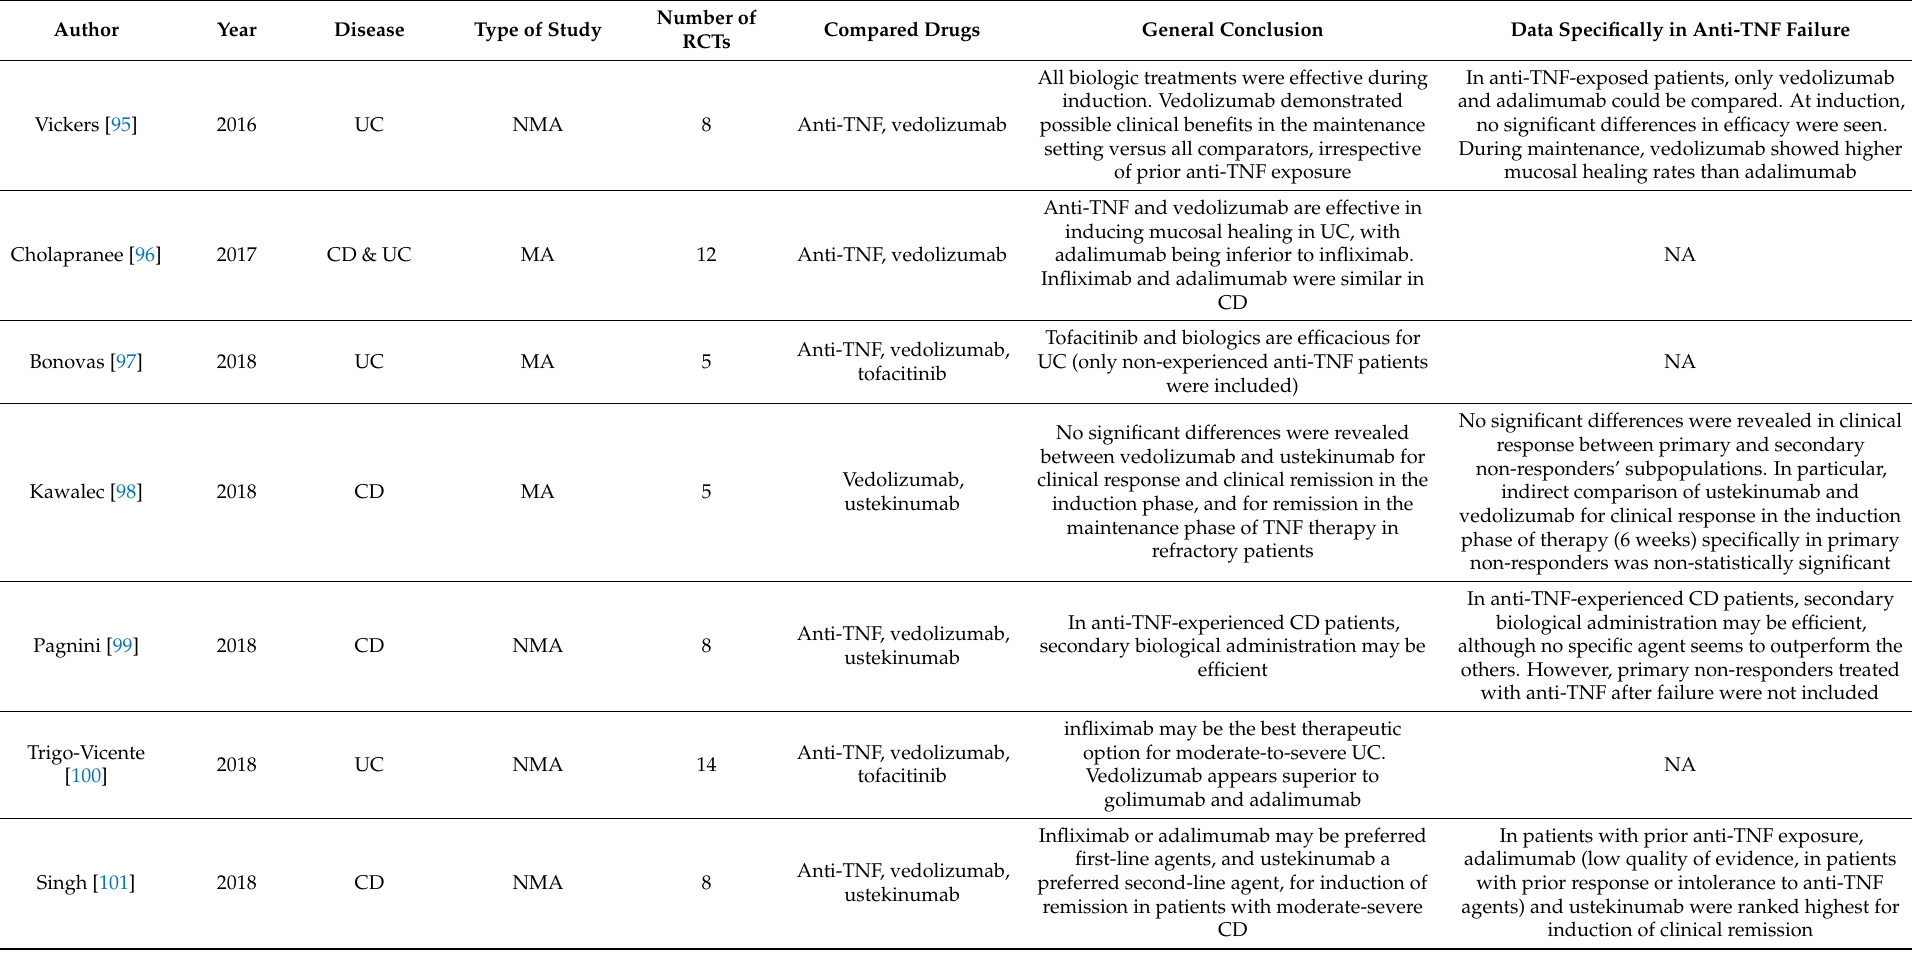
Table 4. Meta-analyses comparing the efficacy of different biologic agents for the treatment of inflammatory bowel